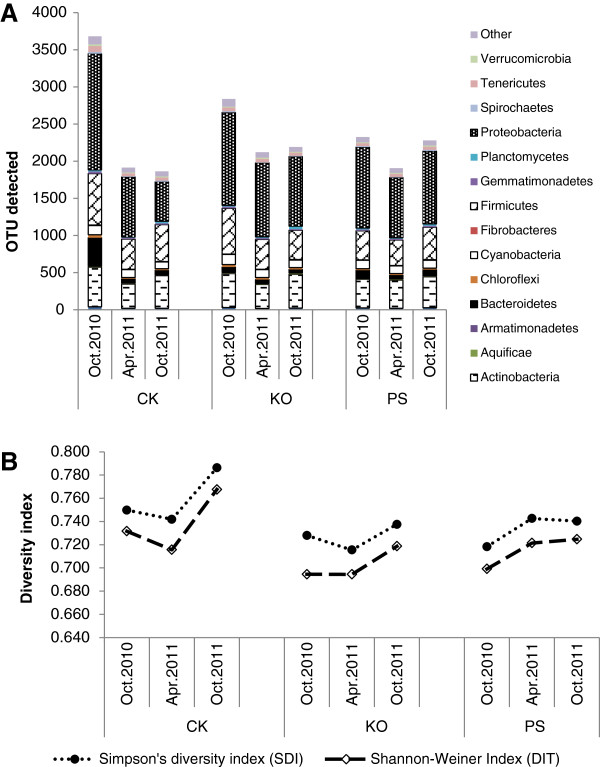
Bacterial richness and diversity in phyla detected by PhyloChip™ G3 hybridization of Huanglongbing (HLB)-affected citrus. The citrus plants were treated with different antibiotic combinations, and leaf samples were collected at different times (October 2010, April 2011 and October 2011) over a year. A, Total operational taxonomic units (OTUs) in each treatment; B, Simpson’s diversity index (SDI) and Shannon-Weiner index (DIT). Each bar represents the coded relative abundance of bacteria in a single phylum. For each treatment, the Simpson’s and Shannon’s diversity statistics, which reflect both species numbers and evenness of species distribution, were plotted below the histogram. PS: 5 g/tree penicillin G potassium and 0.5 g/tree streptomycin; KO: 2 g/tree oxytetracycline and 1.0 g/tree kasugamycin; and CK: water as control.